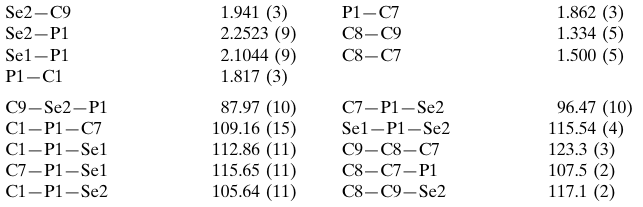
Selected geometric parameters (A˚ , (cid:1)